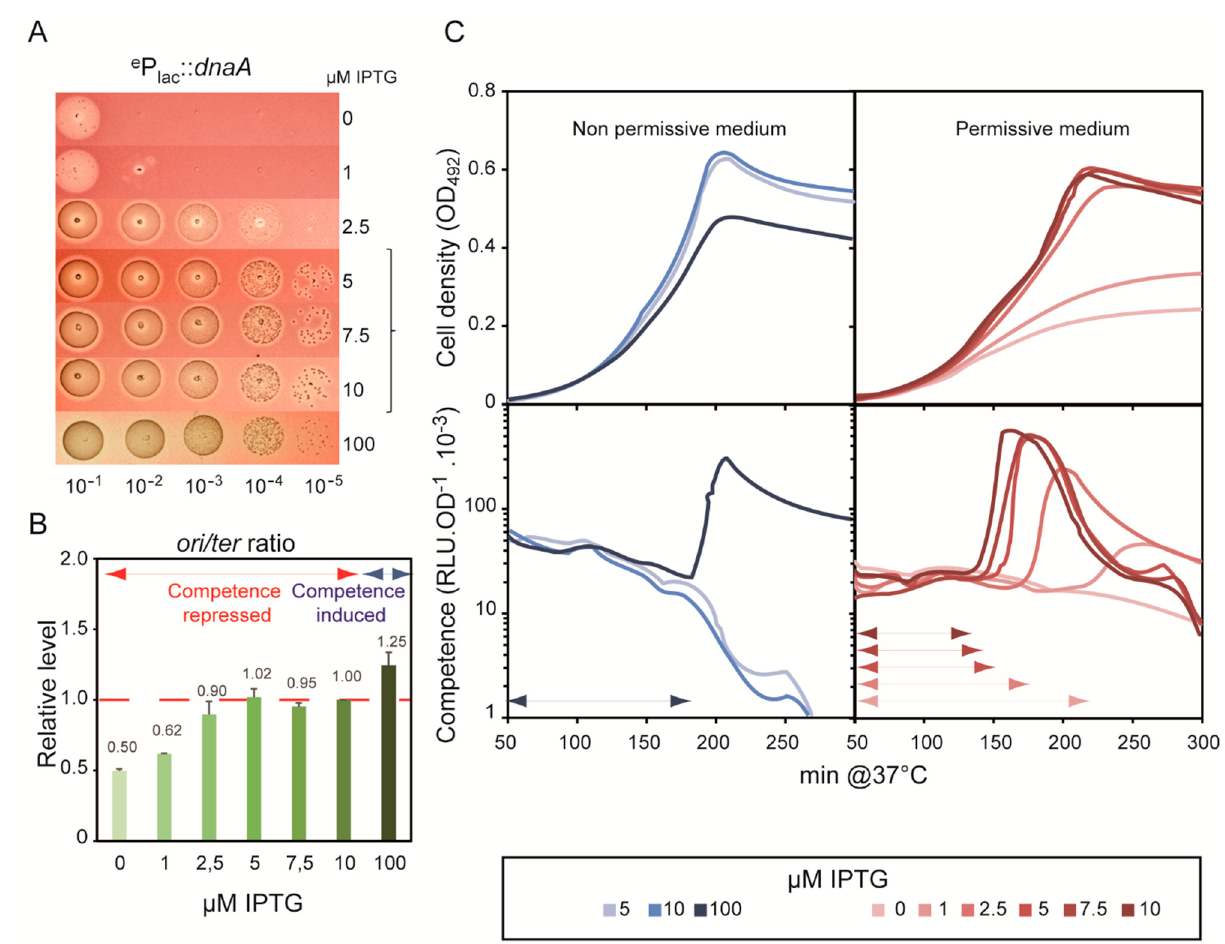
Figure 4. Differential control of competence development by modulated dnaA expression. In strain R3317, the endogenous dnaA promoter has been replaced by the inducible P lac promoter ( e P lac :: dnaA , see Section 2). ( A ): Growth assay. R3317 cells were grown to OD550 = 0.3 and were serially diluted and spotted on plates containing the indicated IPTG concentrations. The bracket covers IPTG concentrations enabling the mutant to mimic WT growth. ( B ): ori / ter ratios measured by qPCR on total DNA extracts from the R3317 strain ( e P lac :: dnaA ) cultivated at the indicated IPTG concentrations and normalized to the ori / ter ratio of cells grown with 10 µM IPTG. The latter ratio also corresponds to the ori / ter ratio of the isogenic WT strain (red horizontal dotted line). The competence development status of each assay is indicated by the blue (induced) and red (repressed) double arrowheads (see Material and methods). The means and standard deviations were based on two replicates. ( C ): Growth (upper graphs) and competence gene expression (lower graphs) of the e P lac :: dnaA strain were monitored in media non-permissive (left panels) or permissive (right panels) for competence development of this strain grown at 10 mM IPTG. Double arrowheads specify the X A period. Curves represent the mean of two replicates. Standard deviations are omitted for clarity.